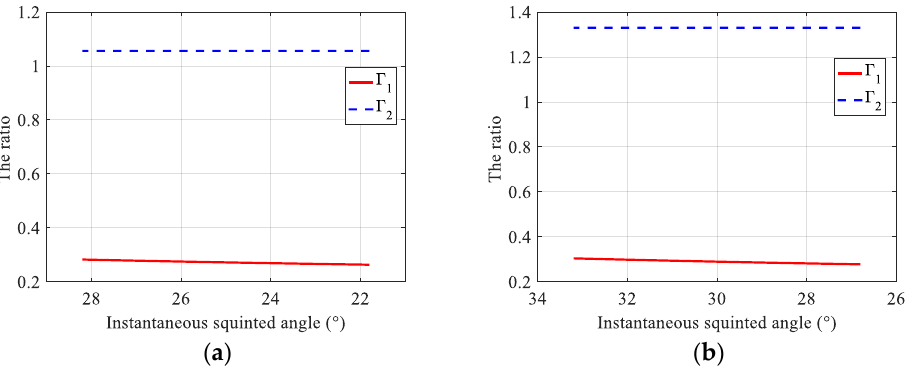
 and  with different squint angles. ( a ) The squint angle in the mid- Figure 2. Comparison of Figure 2. Comparison of Γ 1 and Γ 2 with different squint angles. ( a ) The squint angle in the middle 1 2 dle acquisition interval is 25 ° ; ( b ) the squint angle in the middle acquisition interval is 30 ° . acquisition interval is 25 ◦ ; ( b ) the squint angle in the middle acquisition interval is 30 ◦